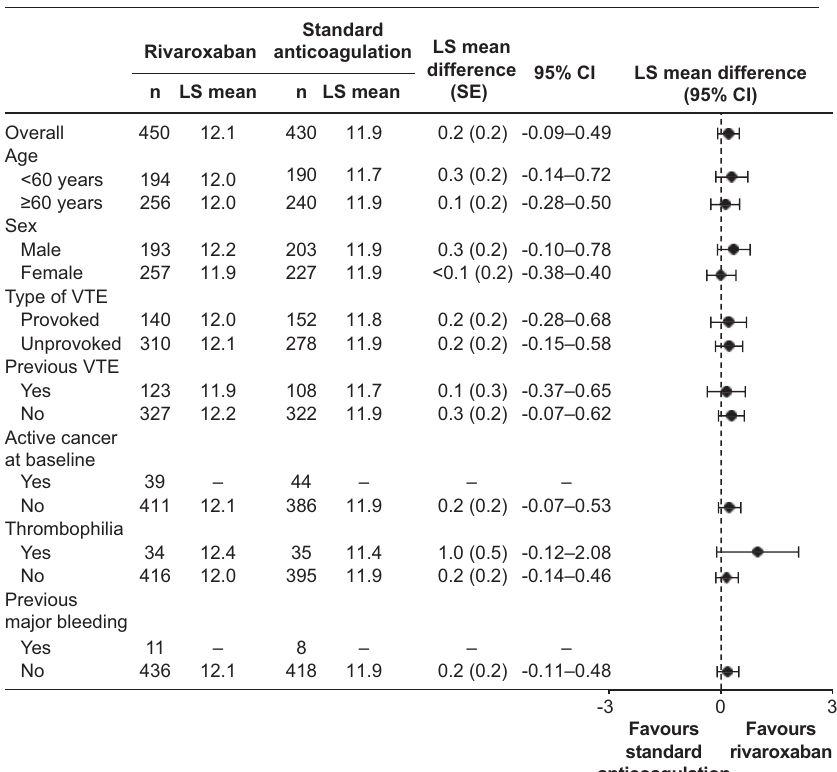
Fig. 2 ACTS Bene fi ts score least squares mean differences by subgroup (PMS-ACTS analysis set). Subgroups with missing values had too few patients to enable LS mean difference to be calculated. ACTS, Anti-Clot Treatment Scale; CI, con fi dence interval; LS, least squares; PMS, propensity score-matched set; SE, standard error; VTE, venous